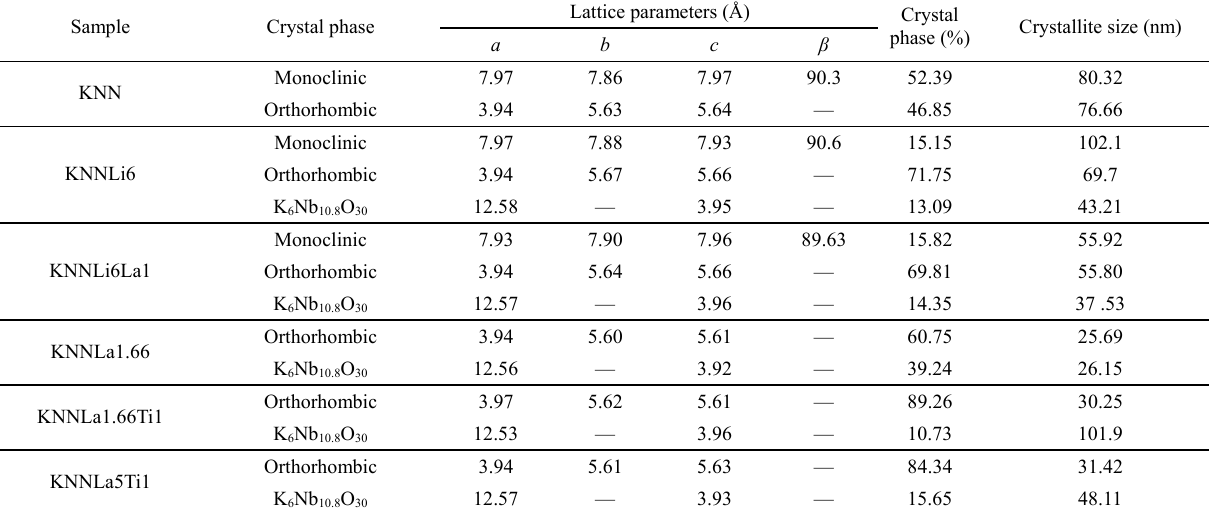
Table 2 Crystal lattice parameters of the crystalline structure of the ceramic samples, obtained by the Rietveld analysis